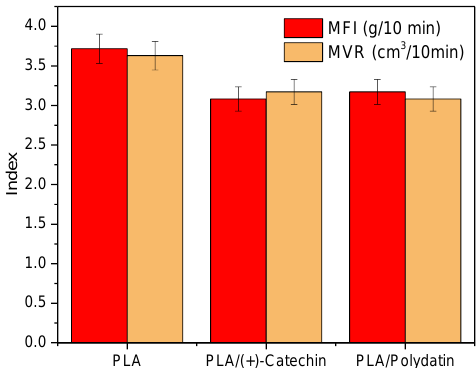
Figure 3. Melt flow index (MFI) and melt volume rate (MVR) of PLA with polydatin and (+)-catechin.